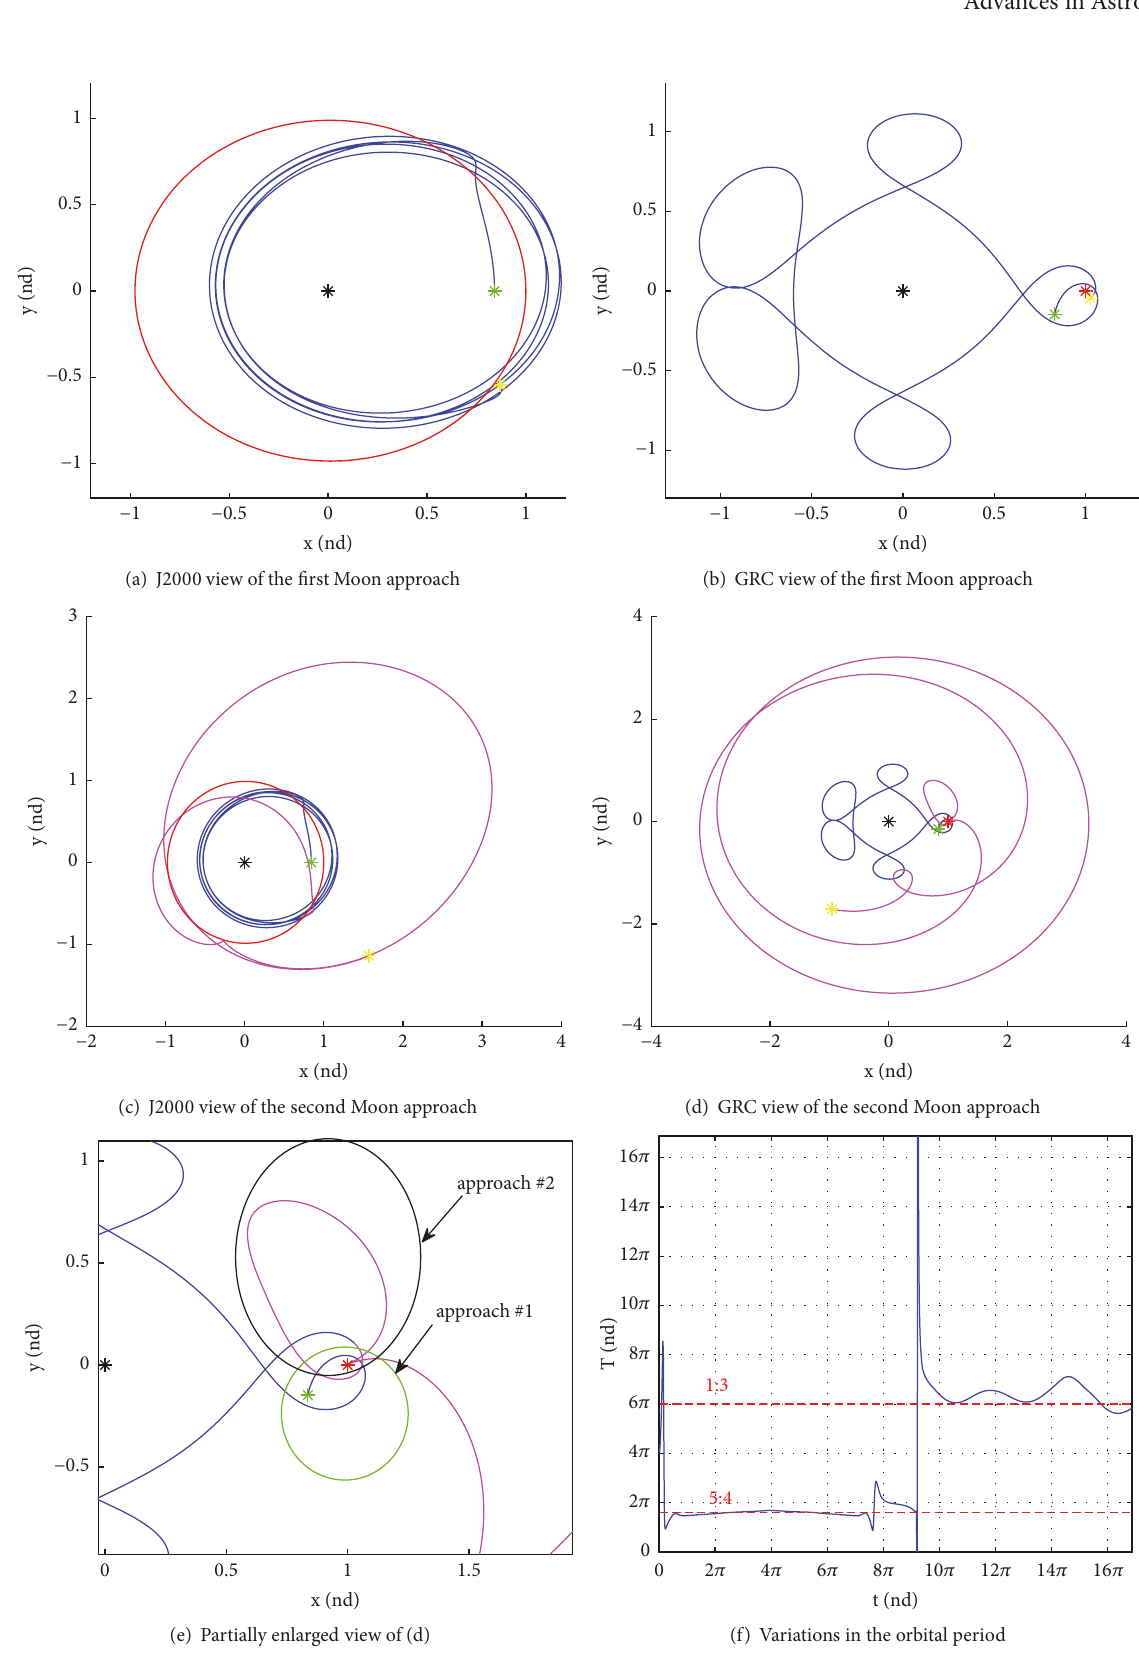
Figure 8: Resonance transition and weak capture by the Moon in the 1:2 resonant orbit with e = 0.47 and 𝜃 0 = 10 ∘